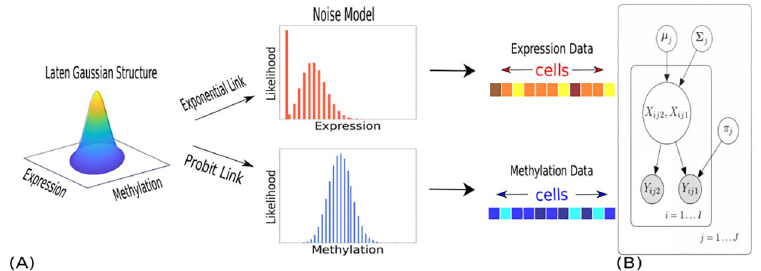
Fig 1. Schematic and graphical representations of SCRaPL. Here, we assume observed data consists of RNA expression and DNA methylation. 1A Schematic representation of the SCRaPL model. 1B SCRaPL’s graphical model, depicting the statistical dependencies between observed genomic data ( Y ij 1 is RNA expression; Y ij 2 is DNA methylation), their associated latent variables ( X parameter π j is specific to the noise model that is assigned to RNA expression data and captures zero inflation. Full details are given in the model description section in Methods .